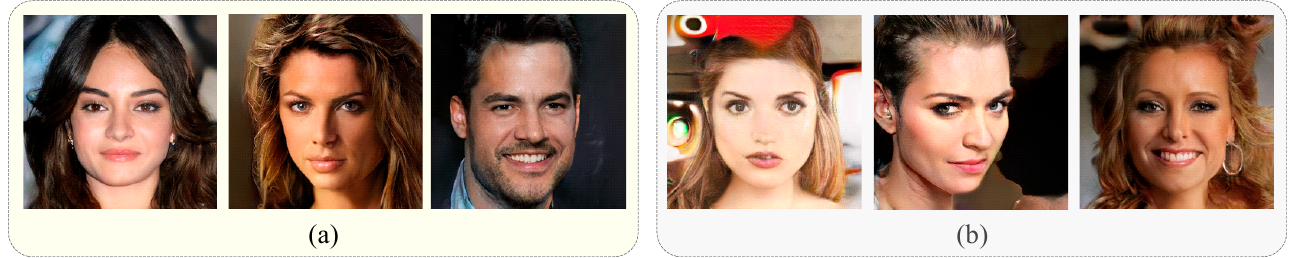
Figure 8. Example of images that are not easy to be detected by local branches. ( a ) the images without the apparent physical traces. ( b ) the images with style transfer.